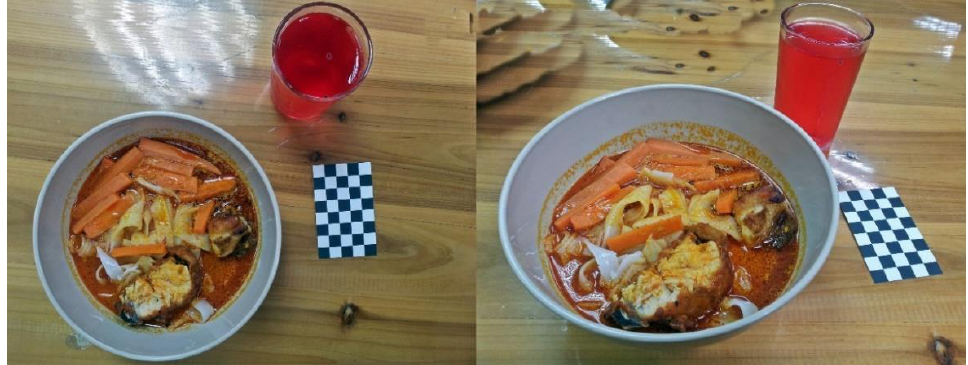
Figure 2. Sample image for Image BW, consisting five items which are rice noodles, curry, chicken, carrots and syrup drink. Image on the left was taken at approximately 90° angle and image on the right was taken at approximately 45° angle. Both images were taken in a lunch setting by a participant from a previous study [27].